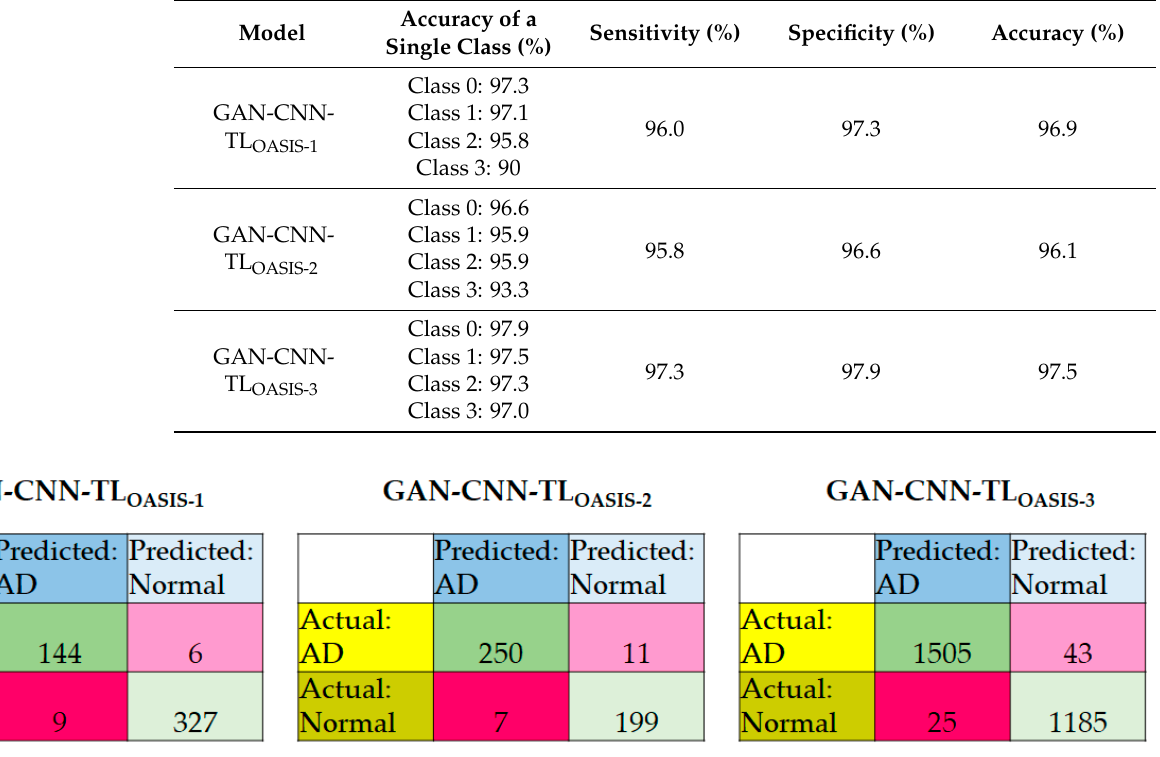
Figure 7. Confusion matrices of the GAN-CNN-TL OASIS-1 , GAN-CNN-TL OASIS-2 , and GAN-CNN- TL OASIS-3 .